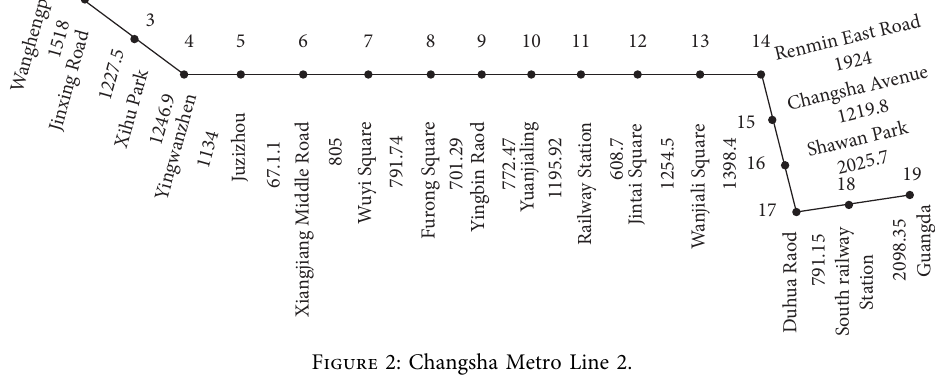
Figure 2: Changsha Metro Line 2.